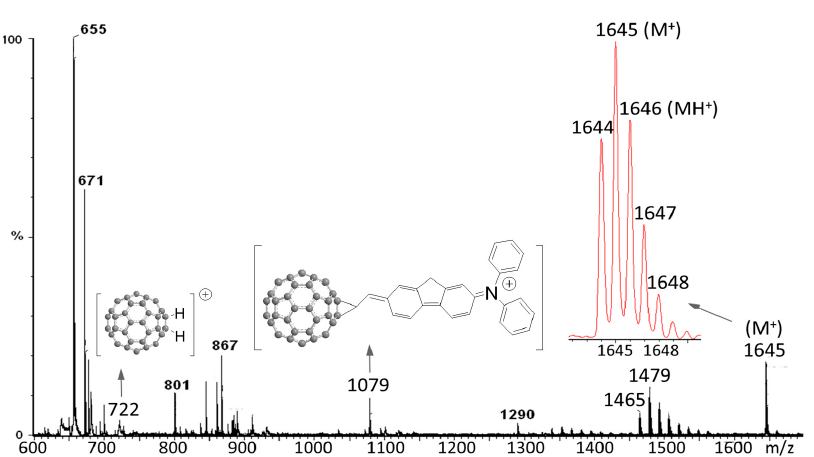
Figure 3. Matrix-assisted laser desorption ionization mass spectrum (MALDI-MS) of C 60 (>CPAF-C 18 ) 1 -C 18 using α -cyano-4-hydroxy-cinnamic acid as the matrix material, showing the molecular ion mass M + (or MH + ).